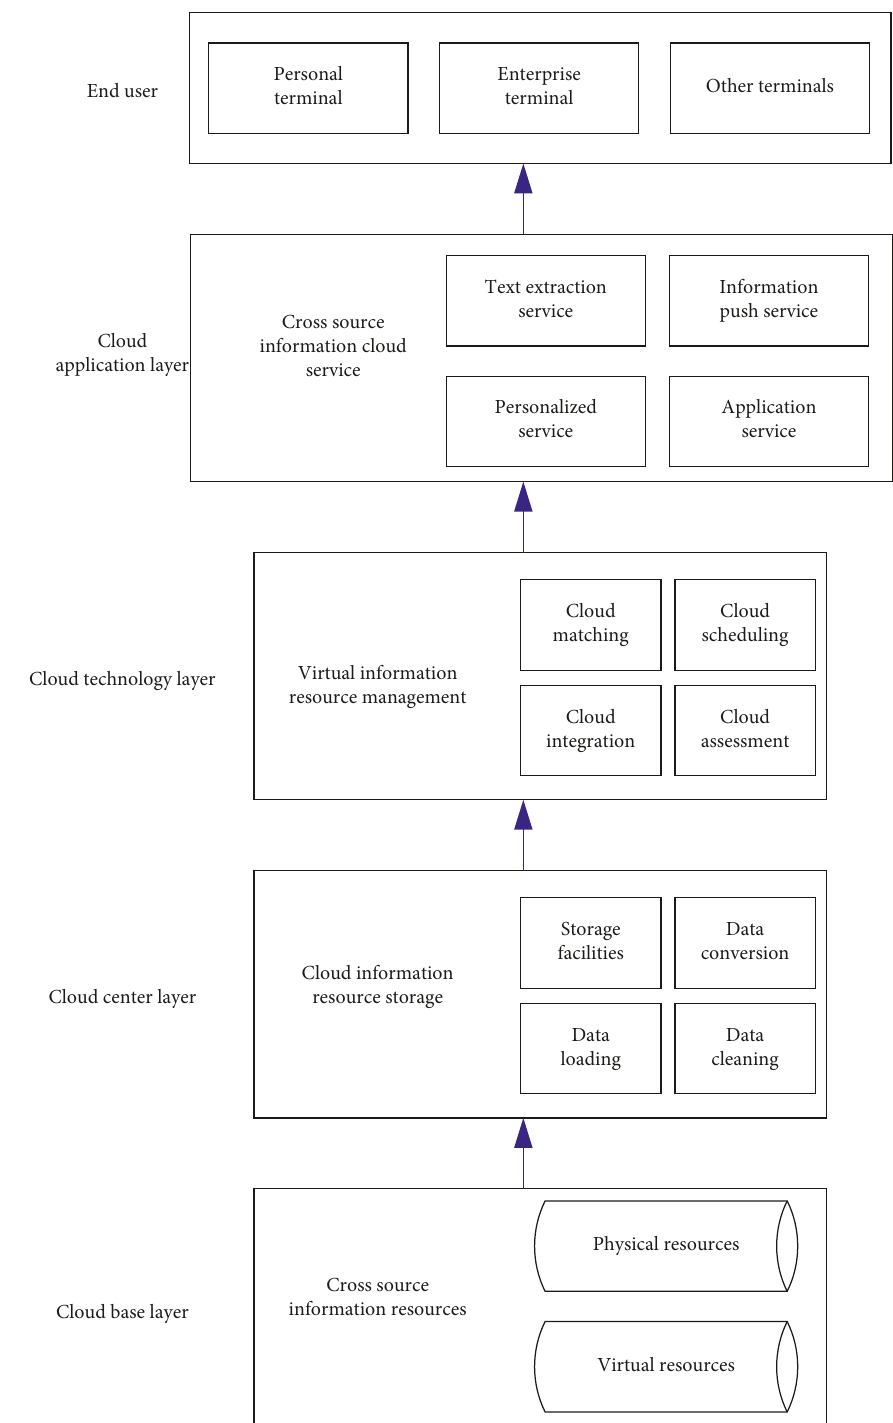
Figure 7: Construction of cross-source education information cloud computing classification model.